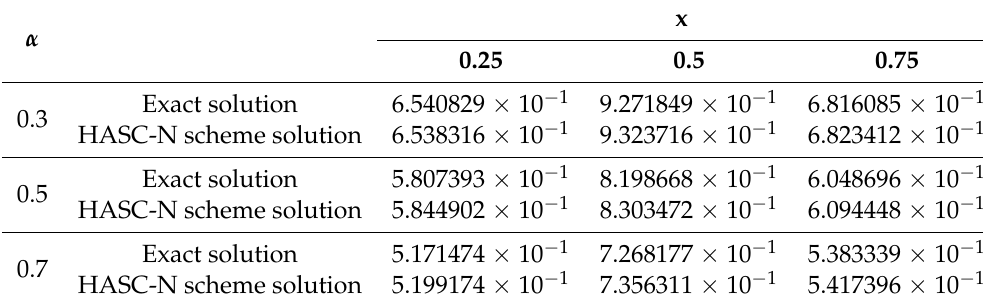
Table 7. Comparison between exact solution and HASC-N scheme solution for Example 3 ( t =